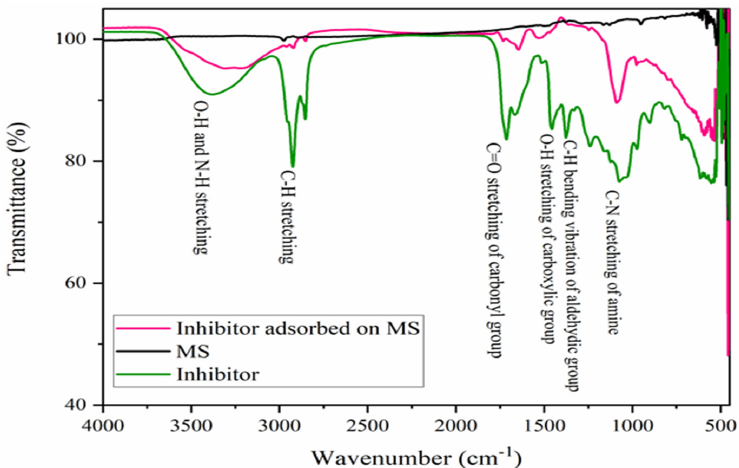
Figure 5. FTIR spectra in the 4000–450 cm − 1 frequency range of MS, inhibitor molecules, and MS immersed in a 600 ppm inhibitor solution for 1 h